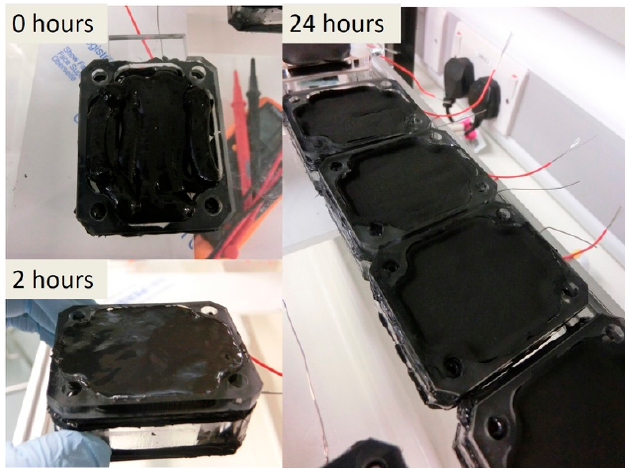
Figure 8. Manually extruded PTFE-free alginate electrode 0, 2 and 24 h after extrusion, showing the electrode settling and solidifying (air-drying).